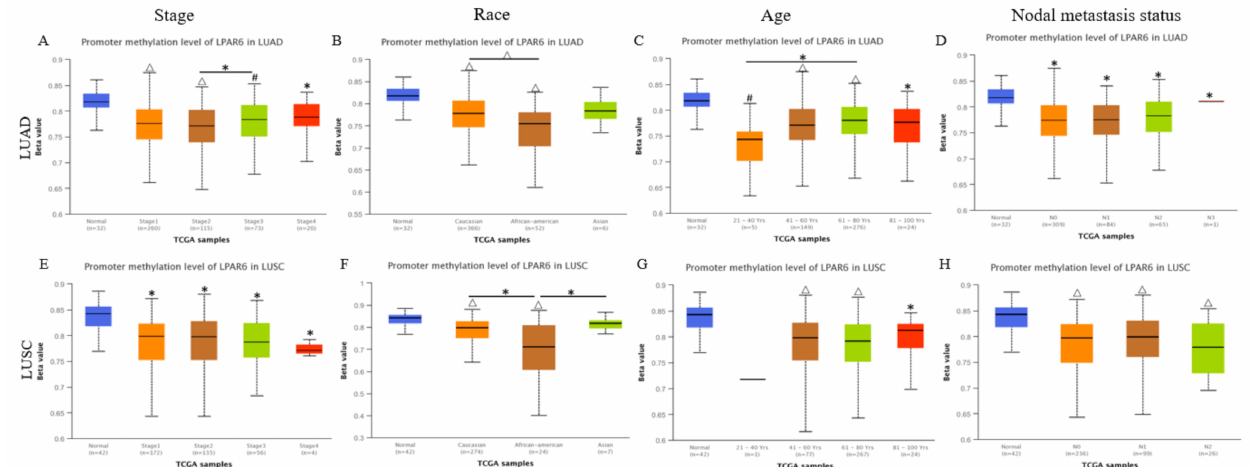
Figure 3. Promoter methylation levels of LPAR6 impacts the clinicopathological parameters. ( A , E ) stage, ( B , F ) race, ( C , G ) age, ( D , H ) nodal metastasis status in LUAD and LUSC cohorts respectively. * p < 0.05 compare with the normal tissue, (cid:52) p < 0.05 compare within different group in the tumor